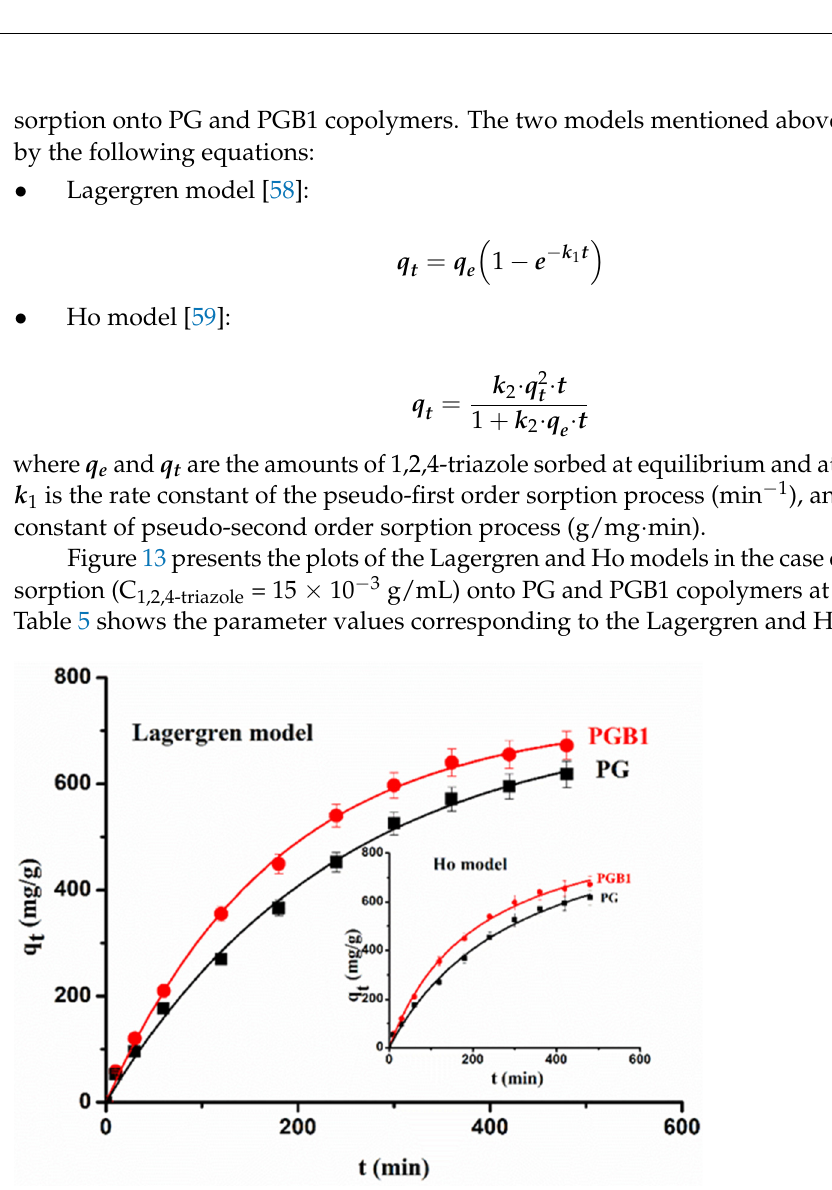
Figure 13. Graphical representation of Lagergren and Ho models in case of 1,2,4-triazole sorption onto PG and PGB1 copolymers at T = 308 K and C 1,2,4-triazole = 15 × 10 − 3 g/mL. Table 5. The parameters corresponding to the Lagergren and Ho models used in the case of 1,2,4-triazole sorption onto PG and PGB1 copolymers .